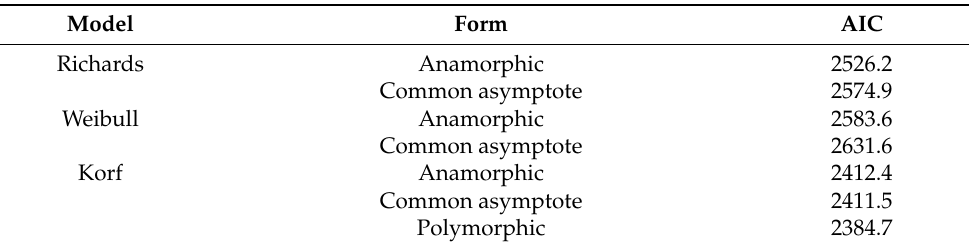
Table 3. Akaike Information Criterion (AIC) of nonlinear mixed models for predicting MTH from stand age.